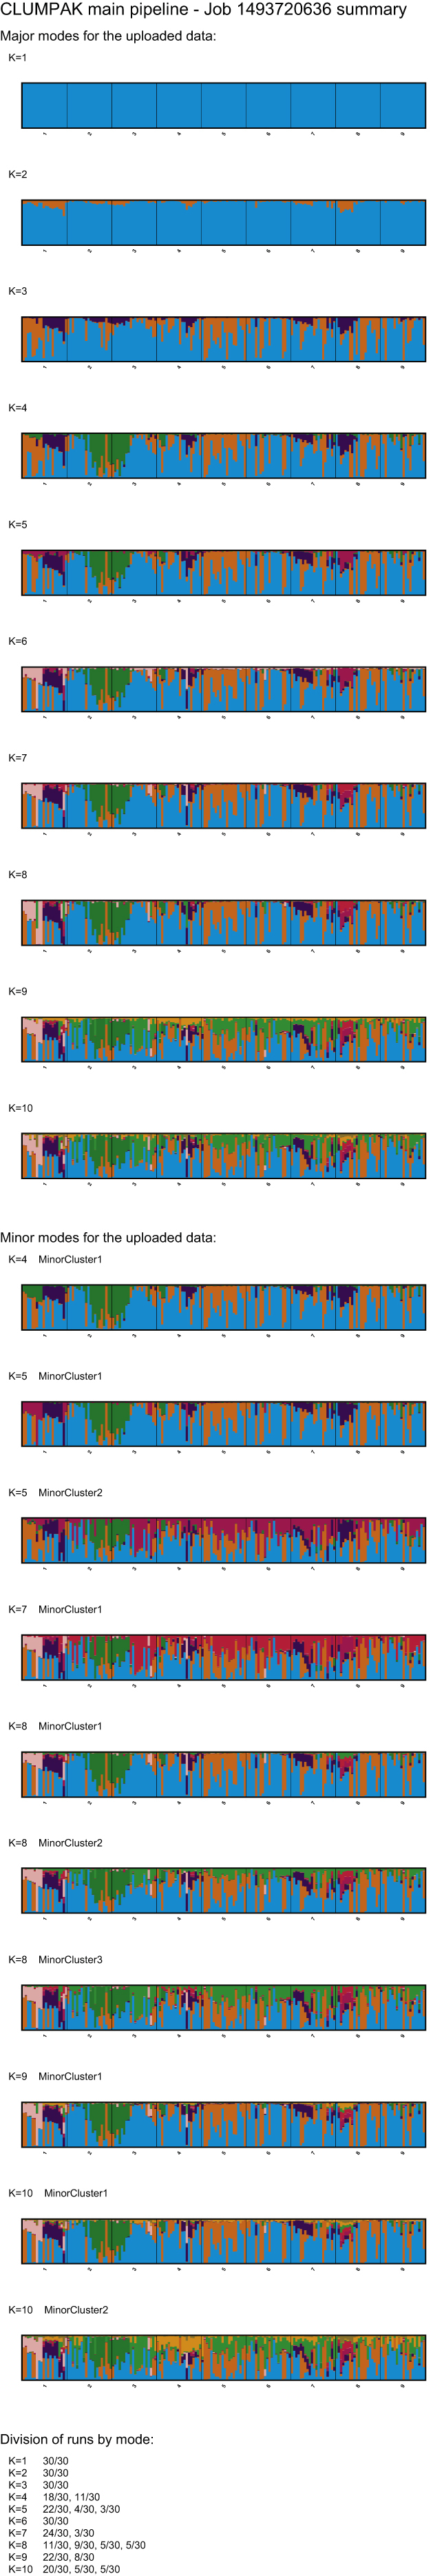
Results of cluster analysis of composition of ISSR-loci of G. conopsea obtained with the Structure program for 9 populations using the “admixture” model. The numbers on the X-axis indicate the numbers of populations (see Table 1).